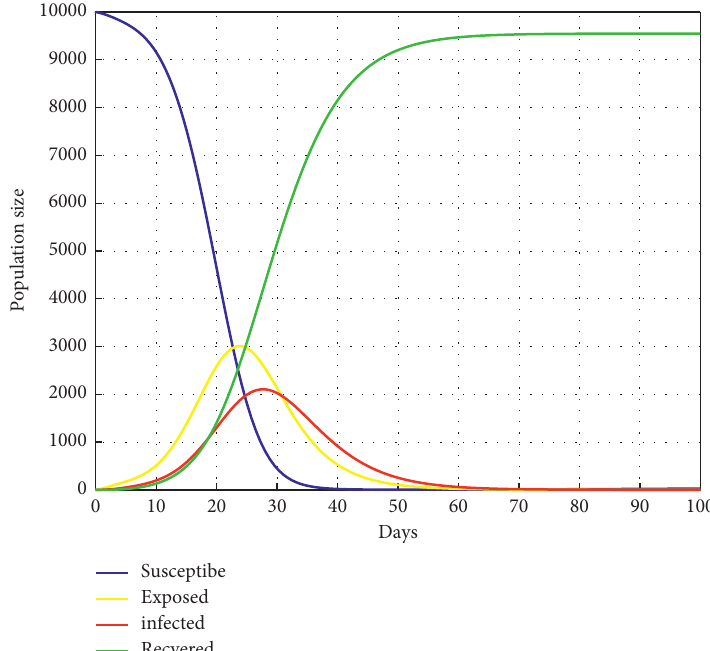
Figure 4: Evolution of the epidemic spreading considering the vector-to-human transmission route and mosquito vertical transmission, i.e., infection incidence rate from host to host β hh � 0.